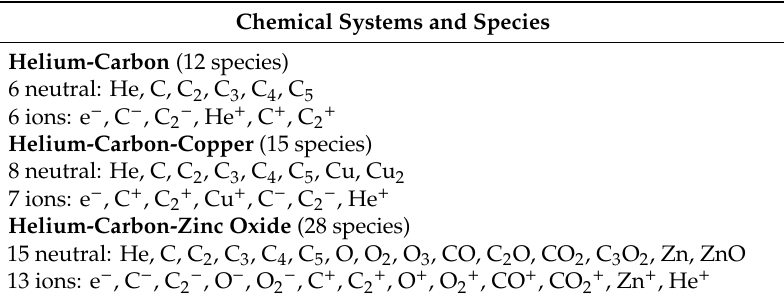
Table 5. Neutral and ion species considered in equilibrium calculations.